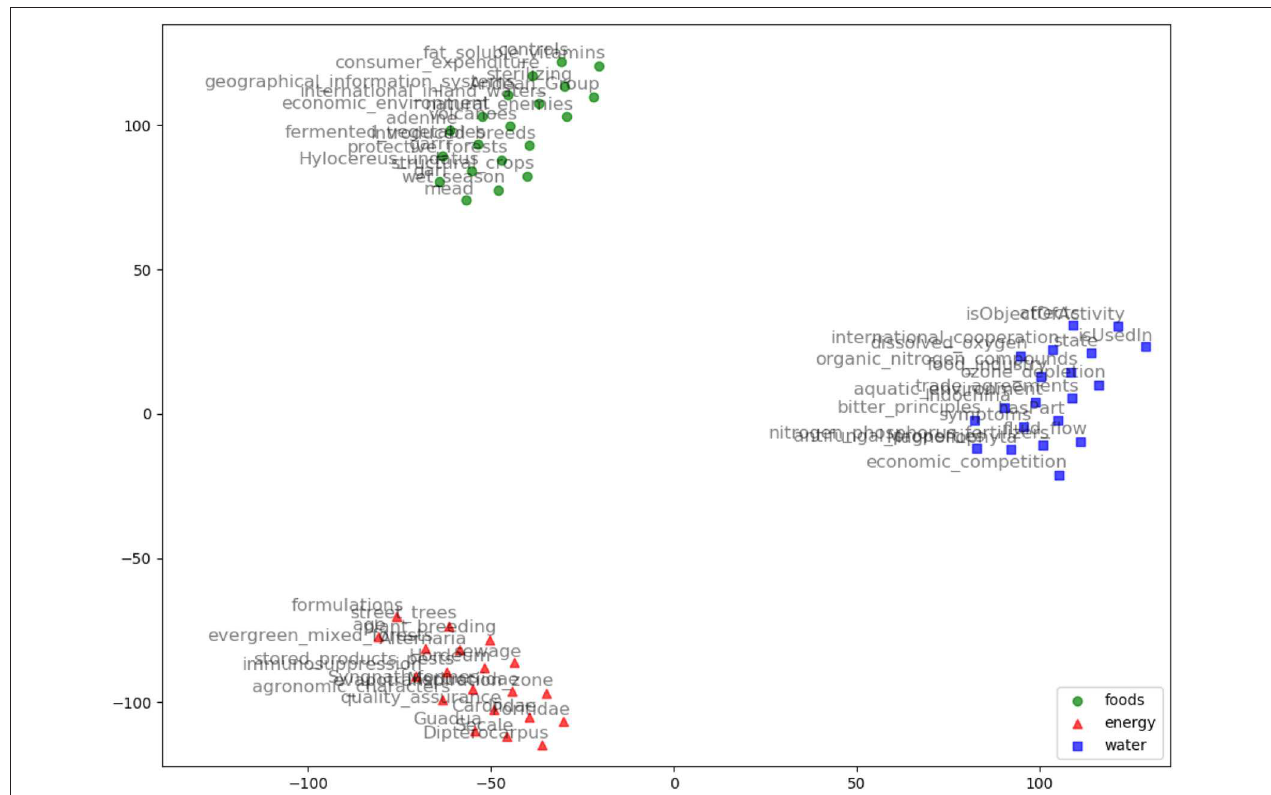
FIGURE 5 | HolE embeddings visualization using TSNE for the words: Food, Energy, and Water with their top 20 nearest neighbors based on HolE